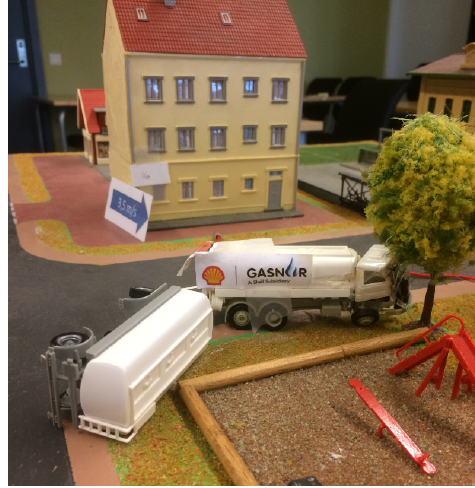
Figure 2. An example of a CS setting facilitating a case-based discussion of a road-tanker incident in a model city on table-top “simulation”. a model city on table-top